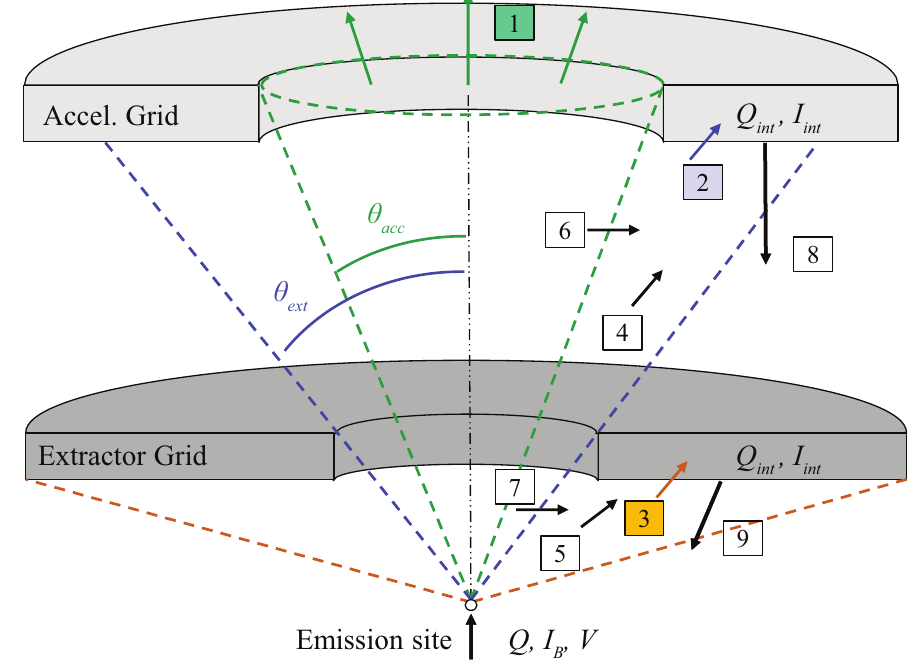
Figure 3. Emission from an electrospray that passes through the accelerator grid produces thrust (1). Additional non-thrust emission pathways exist that lead to lifetime reduction